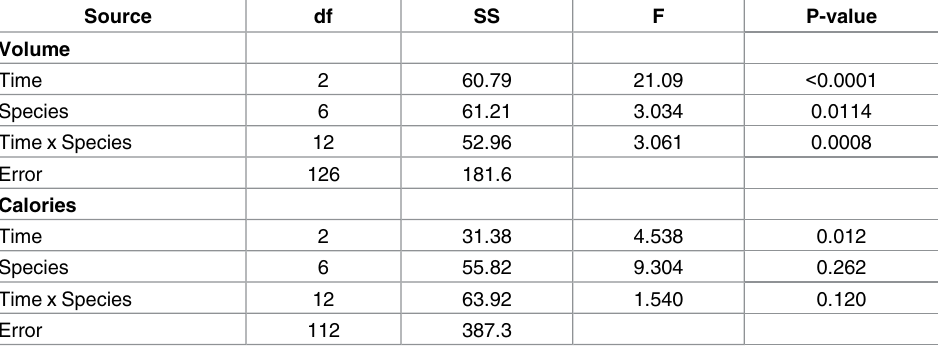
Table 1. Results of two-way ANOVA used to compare the effectsof species, time and both on volume of nectar and quantity of calories produced at the EFNs of seven species assessedat three distinct times of the day.